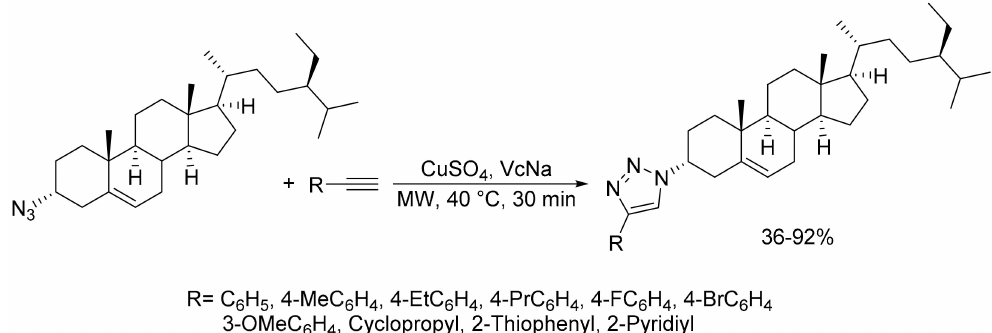
Scheme 16. CuSO 4 catalyzed microwave-assisted synthesis of β -sitosterol derivatives bearing a 1,2,3-triazole